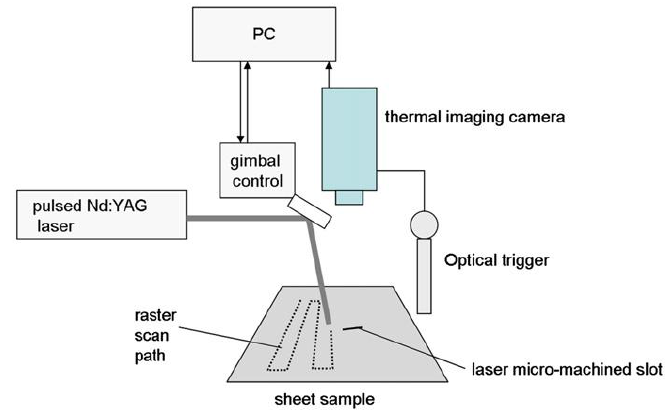
Figure 9. Experimental set-up for laser scanning thermography, with permission from 86.